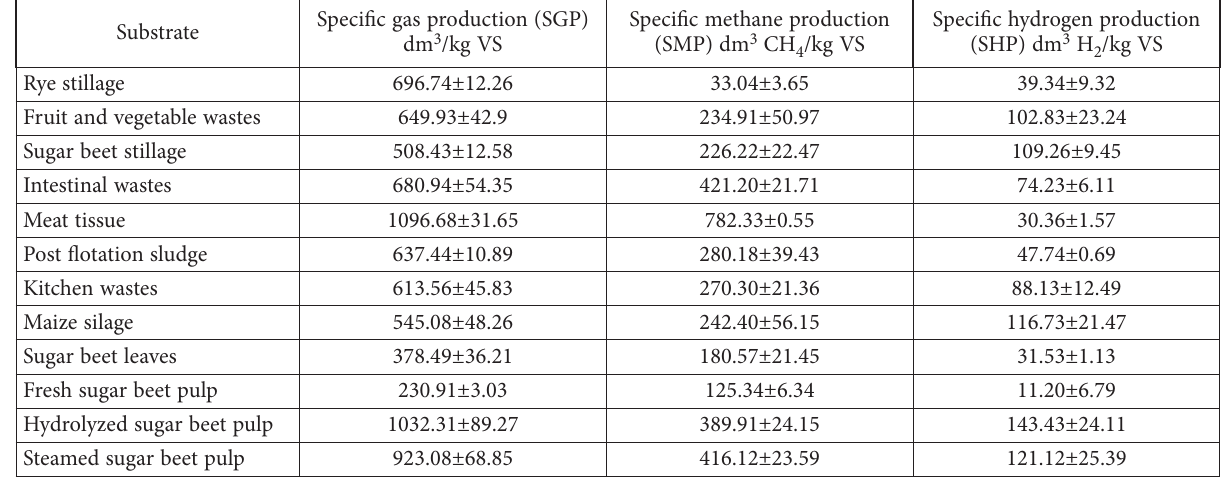
Table 3. Parameters of the batch digestion tests without